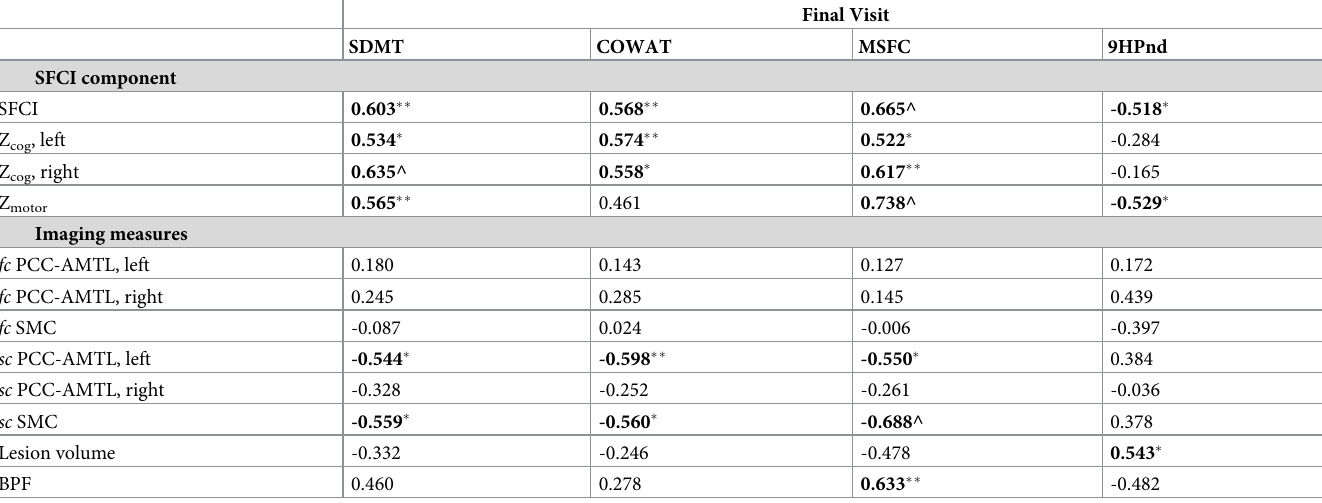
Table 6. Pearson correlation coefficients for the slope of imaging measures related to behavioral measures at the final visit in 20 participants with